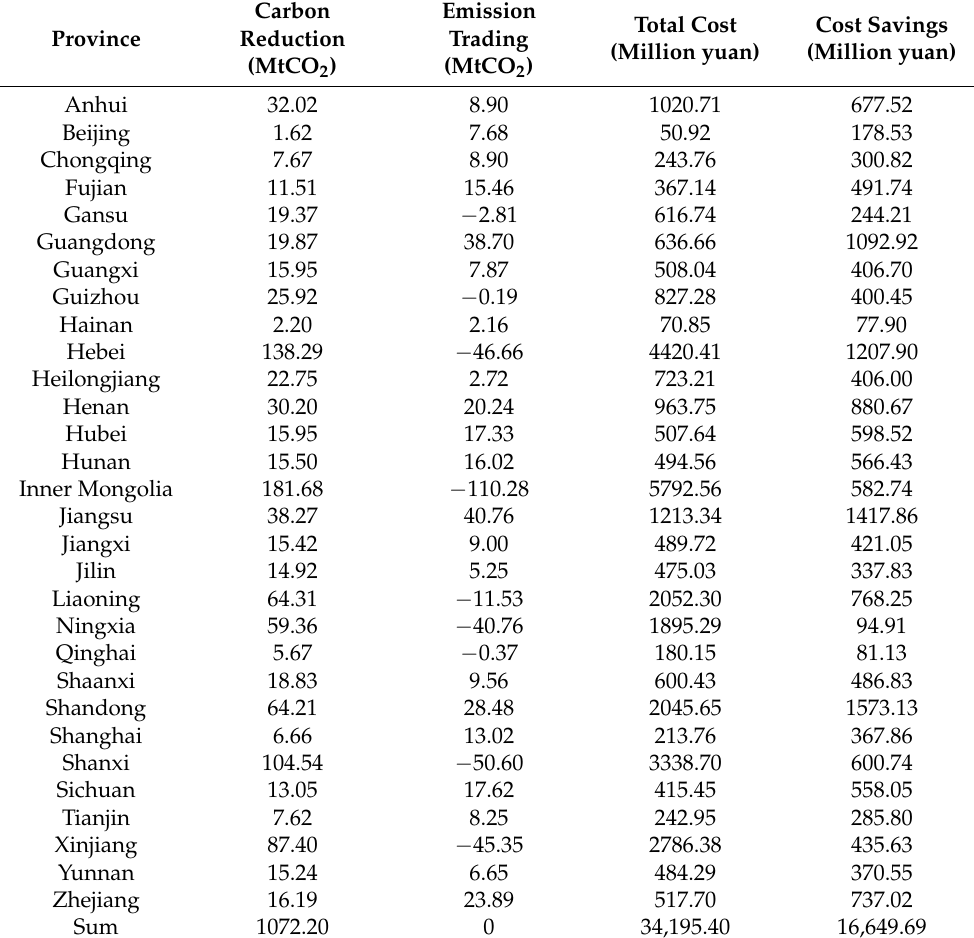
Table 4. Carbon abatement costs by province with national carbon emissions trading